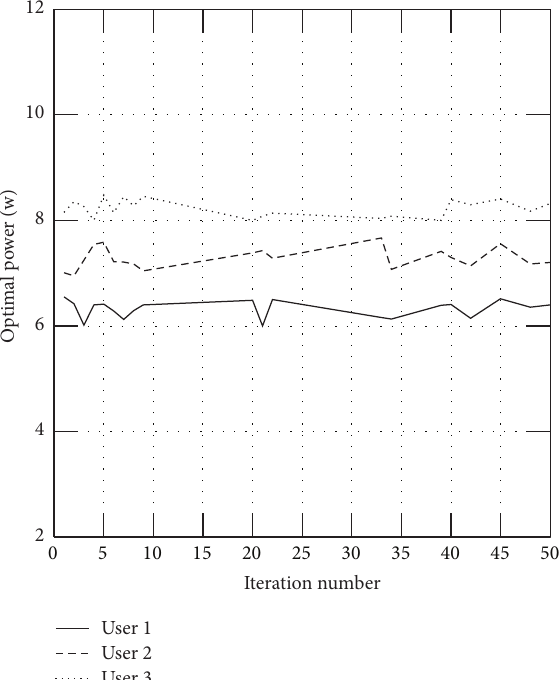
Figure 3: Optimal power with the parameter 𝜆 .